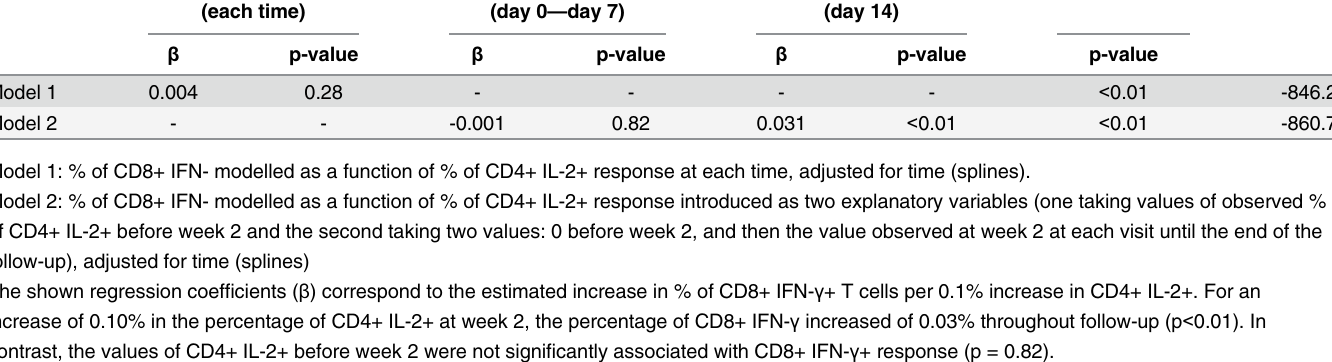
Table 1. Modeling of IFN- γ producing cytotoxic CD8+ T cells (CD8+ IFN- γ + T cells) as a function of IL-2 producing CD4+ helper T cells (CD4+ IL-2 + T cells) and time (model 1 and model 2) in the rAd5-rAd5 group, HVTN 068 trial.